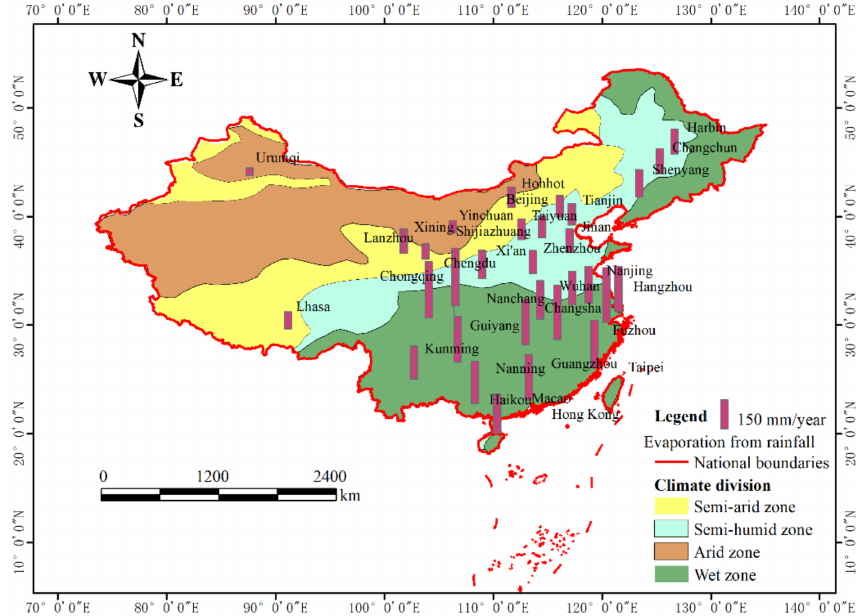
Figure 4. Evaporation intensity of impervious surfaces from rainfall in provincial capital cities in China in